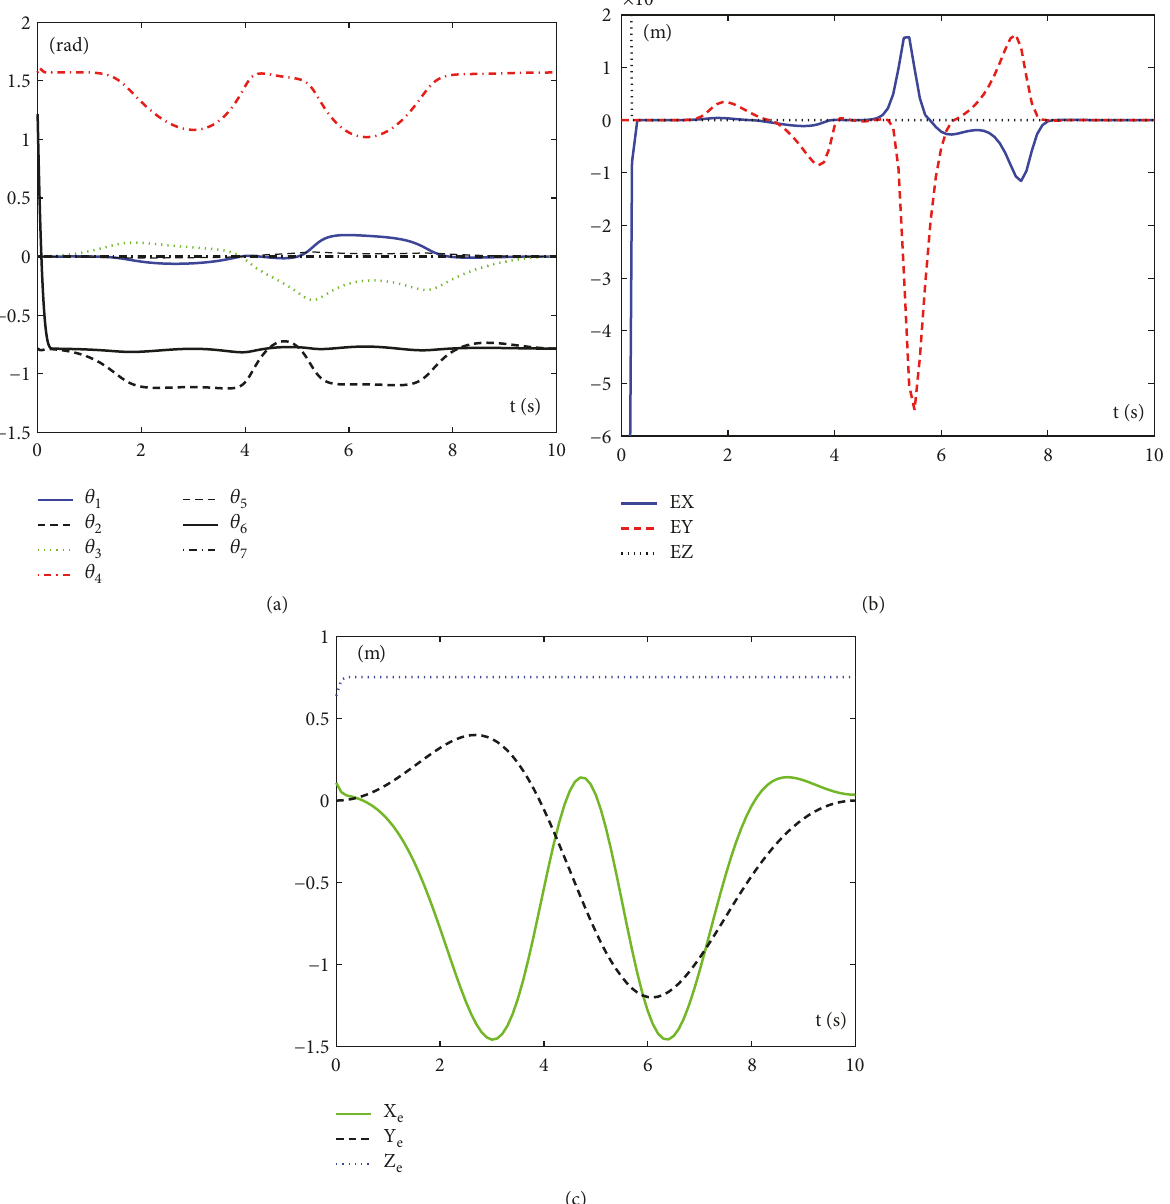
Figure 9: Simulated programs for the repeatable optimization of kinematic energy system (24) under the control of TTZNN. (a) Joints files. (b) Position error of the end-effector (c) Position changing profiles about the end-effector. ̇𝜃 T ̇𝜃/2 for redundant manipulators is set as: minimize